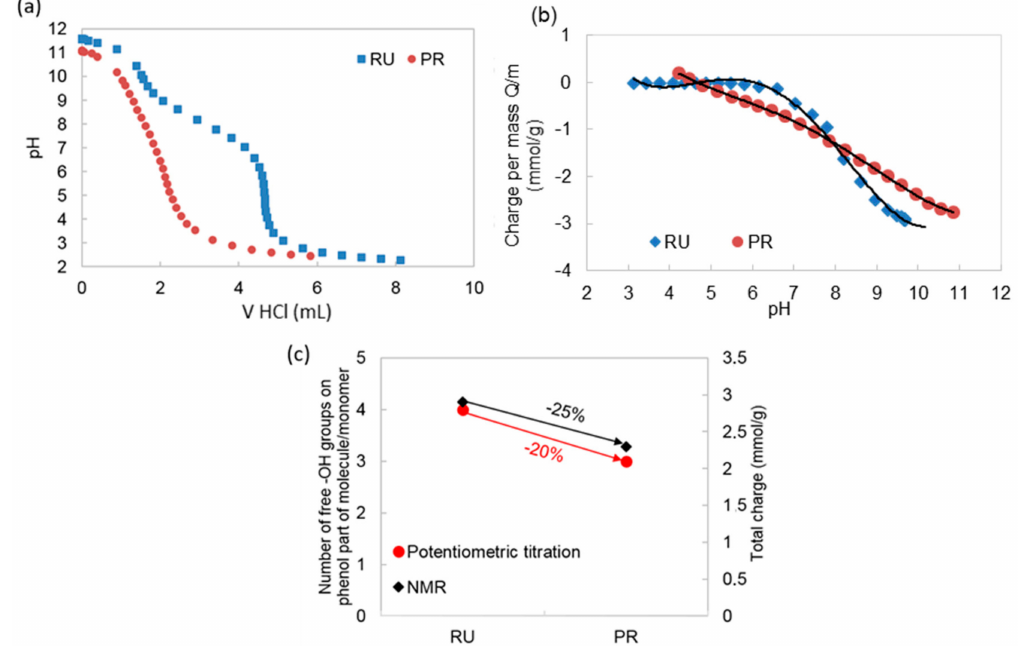
Figure 4. ( a ) Potentiometric charge titration of RU and PR as a function of pH; ( b ) potentiometric charge titration of RU and PR shown as charge per mass as a function of pH; and ( c ) comparison of the number of free phenol hydroxyl groups / monomer, determined using 1 H NMR, with the total charge determined using potentiometric titration for RU and